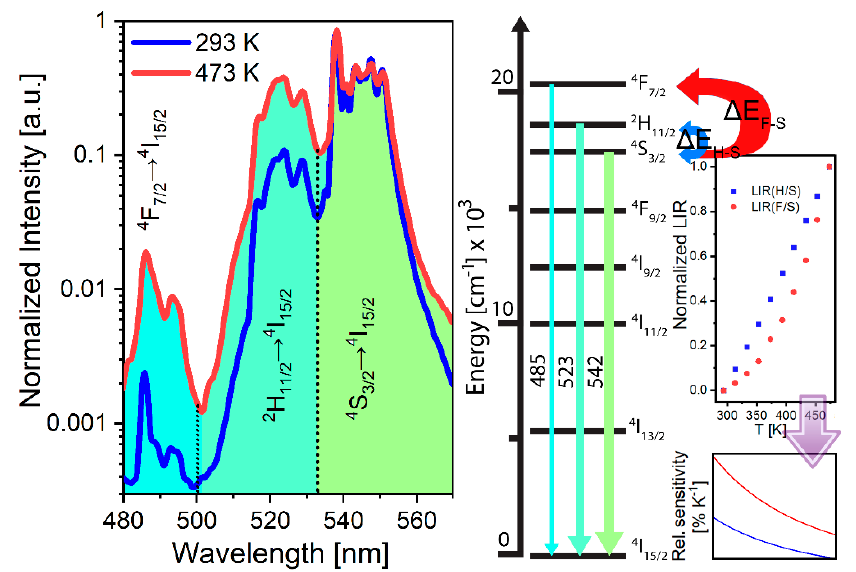
Figure 1. Emission spectra of YF 3 :Er 3+ recorded at 293 K and 473 K, the energy level diagram de- picting the emissions 4 F 7/2 , 2 H 11/2 , 4 S 3/2 → 4 I 15/2 of Er 3+ , the energy difference between 2 H 11/2 and 4 F 7/2 levels from 4 S 3/2 level (blue and red arrows, respectively), the normalized LIRs of 2 H 11/2 → 4 I 15/2 / 4 S 3/2 → 4 I 15/2 and 4 F 7/2 → 4 I 15/2 / 4 S 3/2 → 4 I 15/2 and the corresponding relative sensitivities on the given temperature range.